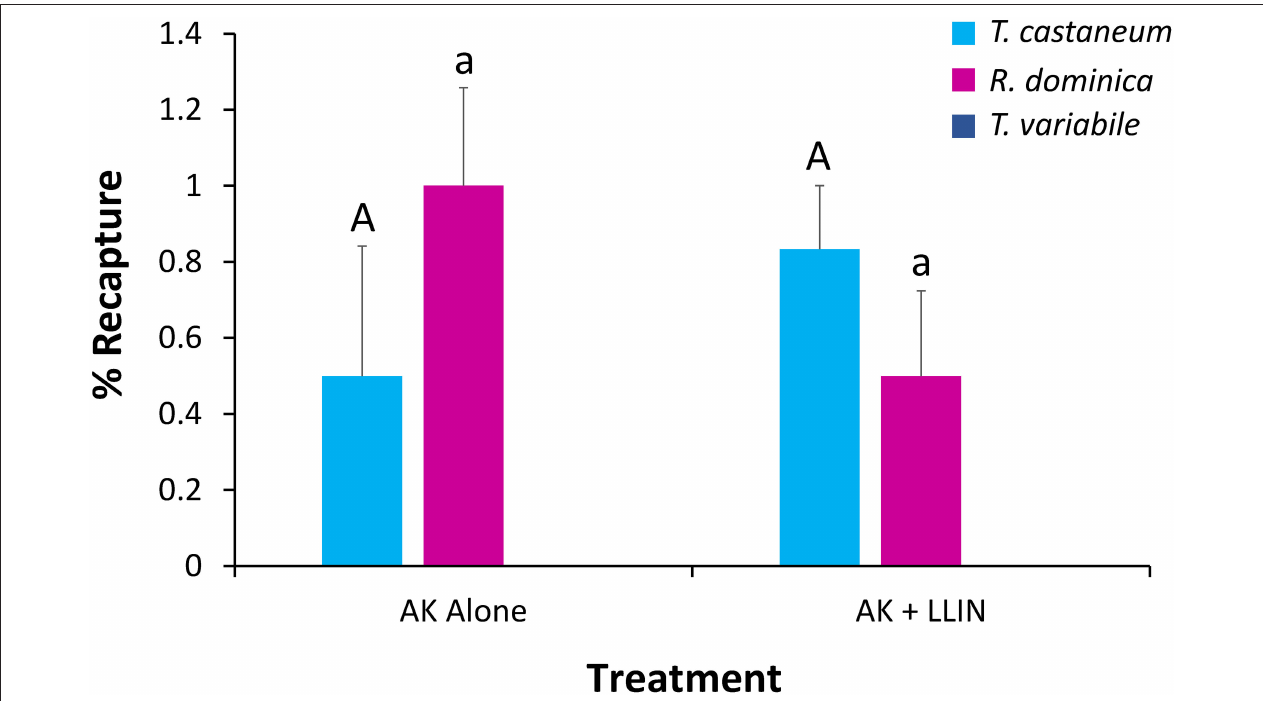
FIGURE 11 | Mean (SE) percentage of 100 T. castaneum (light blue bars), R. dominica (pink bars), and T. variabile (dark blue bars) recaptured in AK-based interception traps deployed in pilot-scale warehouses during Trial 2 in Manhattan, KS in 2019. Lower case letters represent pairwise comparisons within R. dominica , while upper case letters represent pairwise comparisons within T. castaneum . Bars with shared letters are not significant different from each other (Tukey HSD, α =